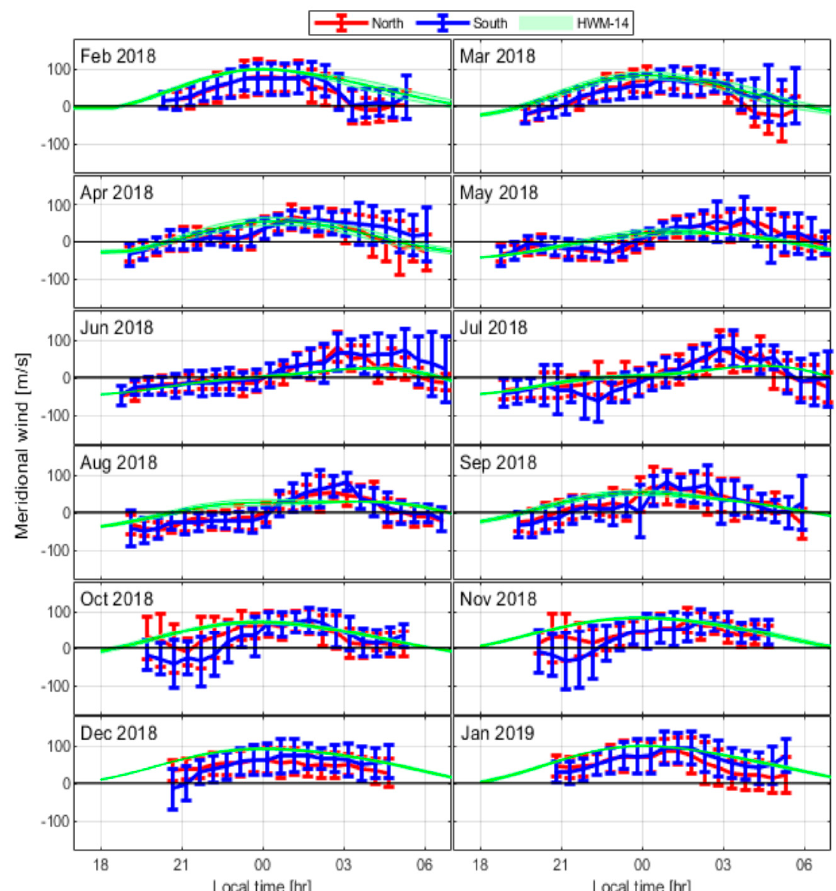
Figure 2. Meridional winds in Morocco for January 2014 to February 2016. The blue plots represent the FPI measurements, while the green plots represent corresponding HWM-14 predictions. The vertical error bars indicate the standard deviations of the observations. Adapted with permission from Ref. [23]. 2017, Kaab et al.